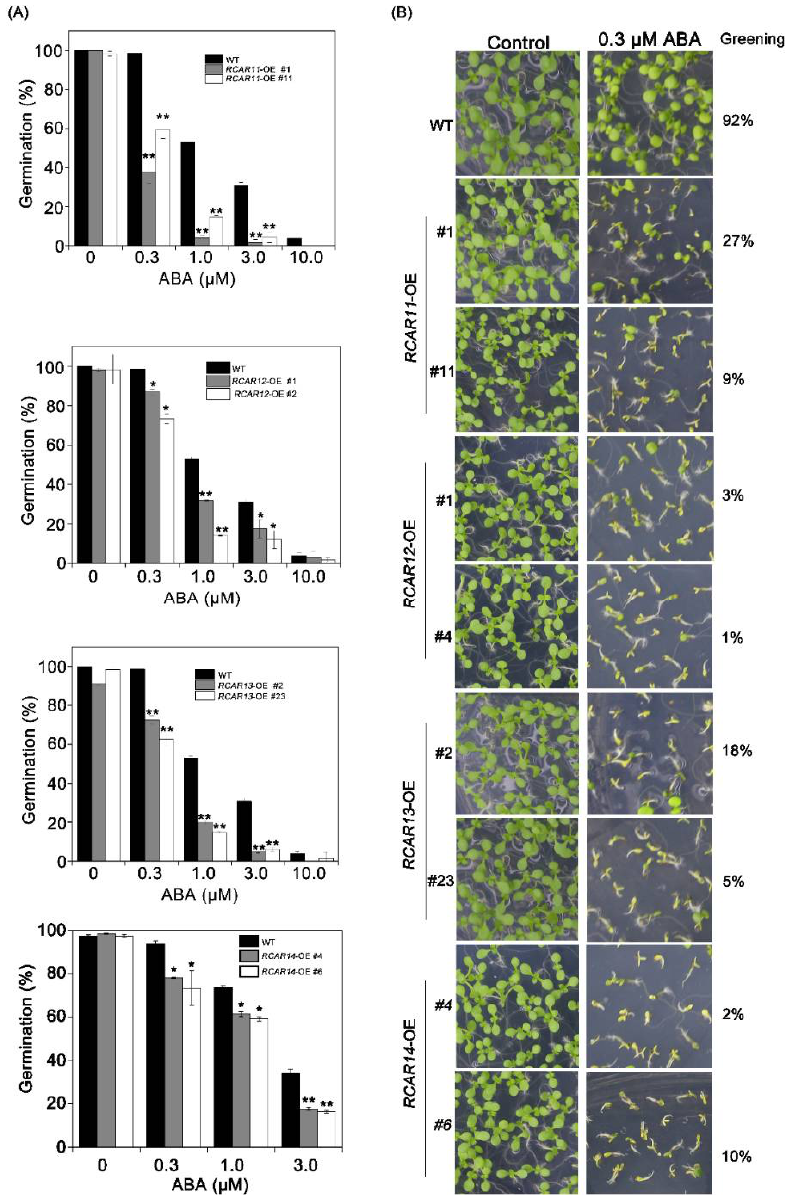
Figure 2. The germination and early seedling growth of the transgenic plants in response to ABA. ( A ) The seed germination rates of wild-type (WT) and RCAR11/12/13/14 overexpression transgenic plants in the presence of ABA on the fourth day after stratification at 4 °C for 3 days; ( B ) Phenotypic analysis of WT and transgenic lines were grown on the MS medium with or without ABA and the green cotyledons were recorded 7 days after the stratification at 4 °C for 3 days. The green cotyledon percentage is indicated on the right. The experiments were repeated three times with similar results. Values are means ± SD ( n > 100) of three independent experiments (* p < 0.05, ** p < 0.01, Student’s t - test).